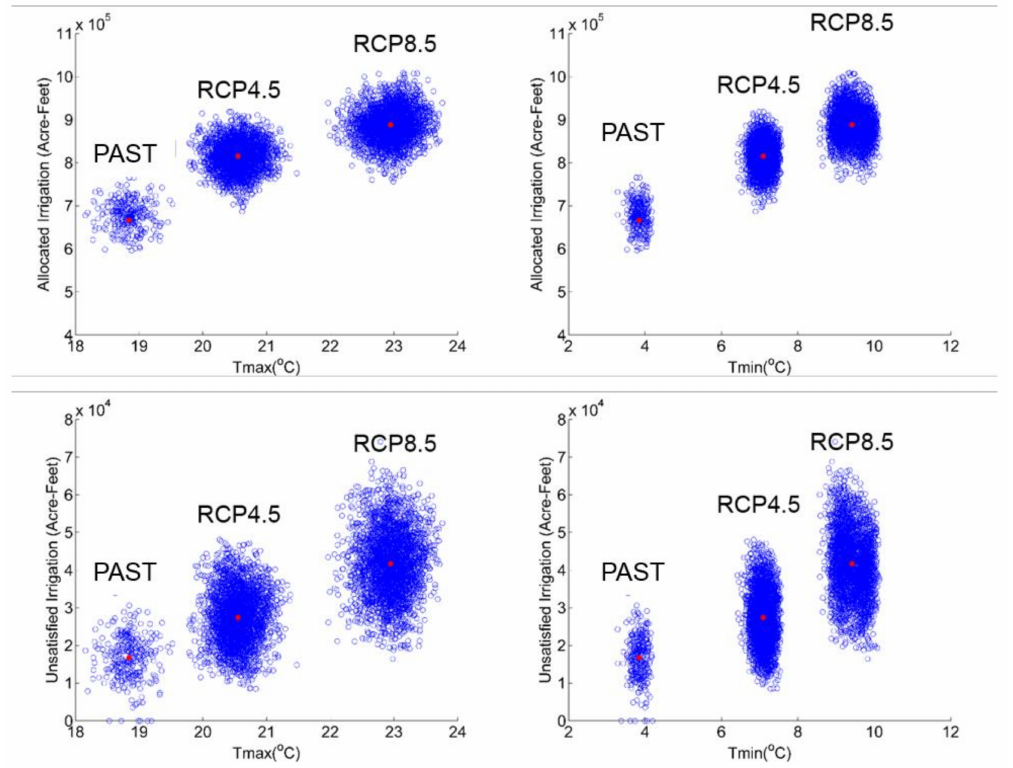
Figure 10. The scatterplot of the allocation irrigation amount and the unsatisfied irrigation amount with maximum and minimum temperature under three scenario groups. The solid dots indicate the mean values of each scenario group.